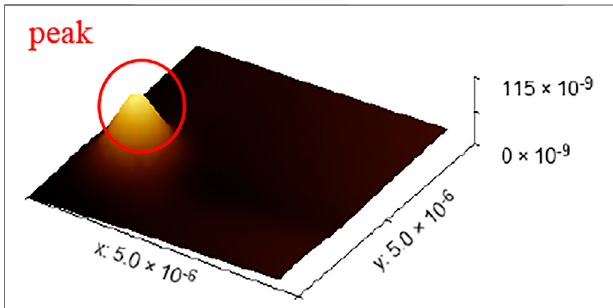
FIGURE 15 | Reasons for the impact of measurement